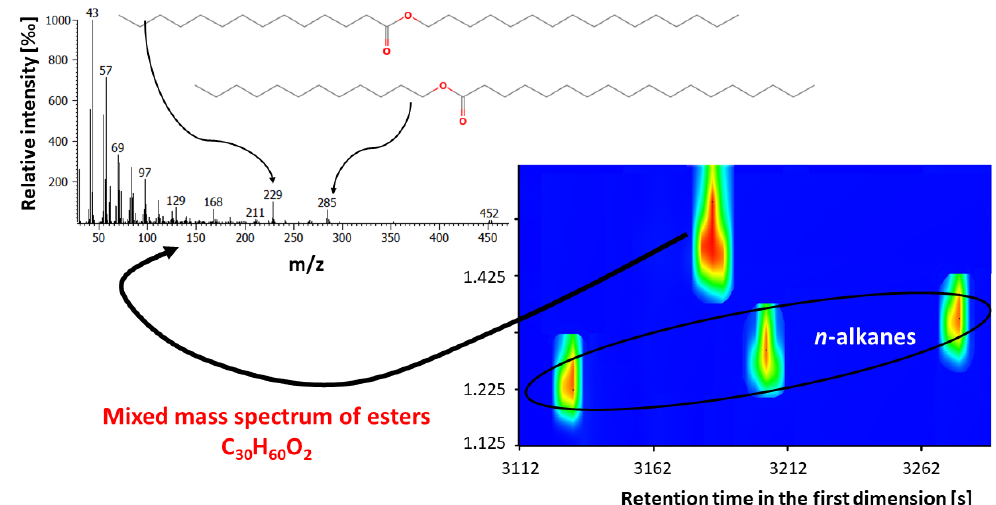
Figure 2. The mixed mass spectrum of hexadecyl ester of tetradecanoic acid and dodecyl ester of octadecanoic acid. The arrows indicate their typical m / z , which correspond to the loss of the alkyl chain of the alcohol associated with the migration of two hydrogens.